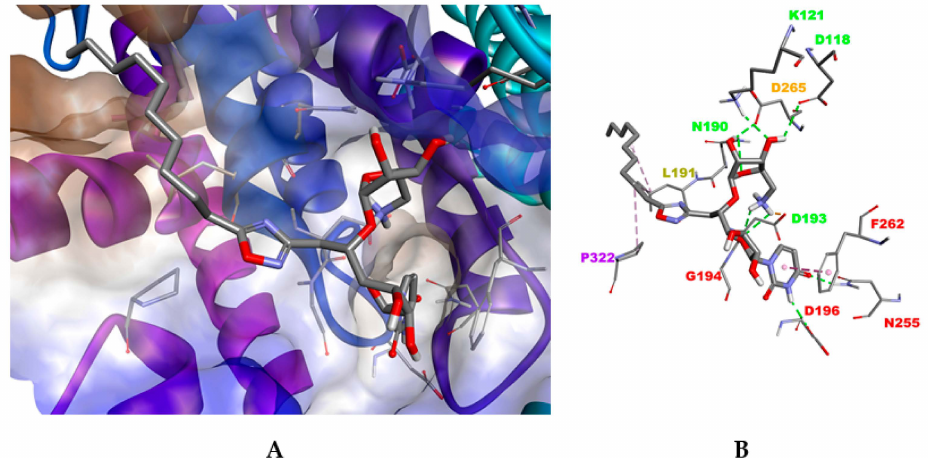
Figure 4. Docking pose for a compound in the closed conformation of MraY AA (PDB ID: 6OYH). ( A ). The hydrophobic surface is rendered as brown and the hydrophilic surface as blue. Ligand and residues are shown in stick mode. ( B ). Interactions between the inhibitor 12a and MraY AA are shown as colored dashed lines: hydrophobic interactions (magenta), electrostatic interactions (orange) and hydrogen bond (green). For clarity, the apolar hydrogen atoms are